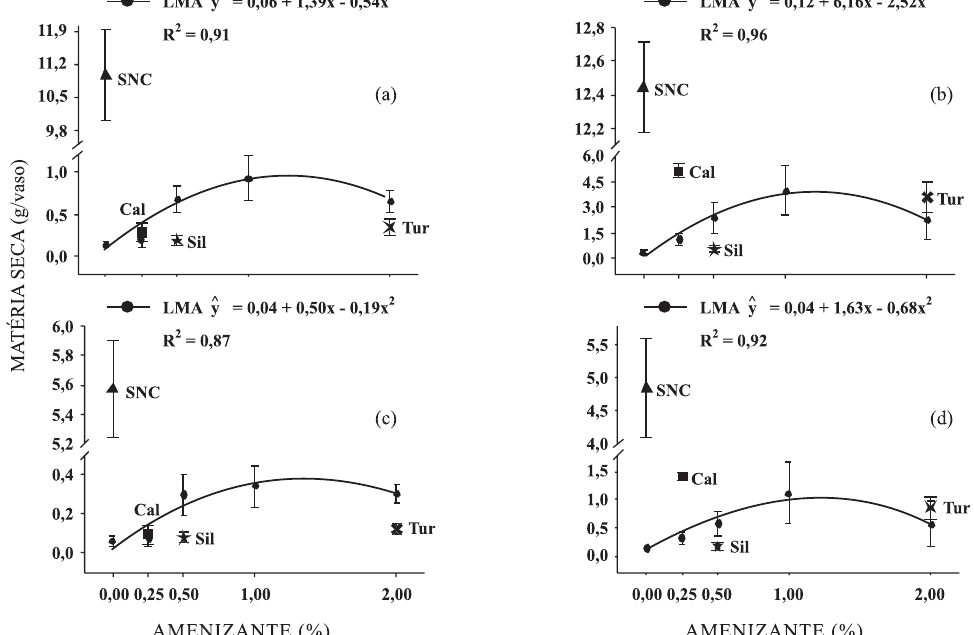
Figura 5. Valores médios da matéria seca da parte aérea (MSPA) e raiz (MSR) de Brachiaria decumbens (g/vaso), respectivamente, do Neossolo Quartzarênico (a e c) e do Latossolo Vermelho (b e d) contaminados com Cd e Pb. LMA: lama da mineração de Al, SNC: solo não-contaminado, Cal: calcário, Sil - silicato e Tur: